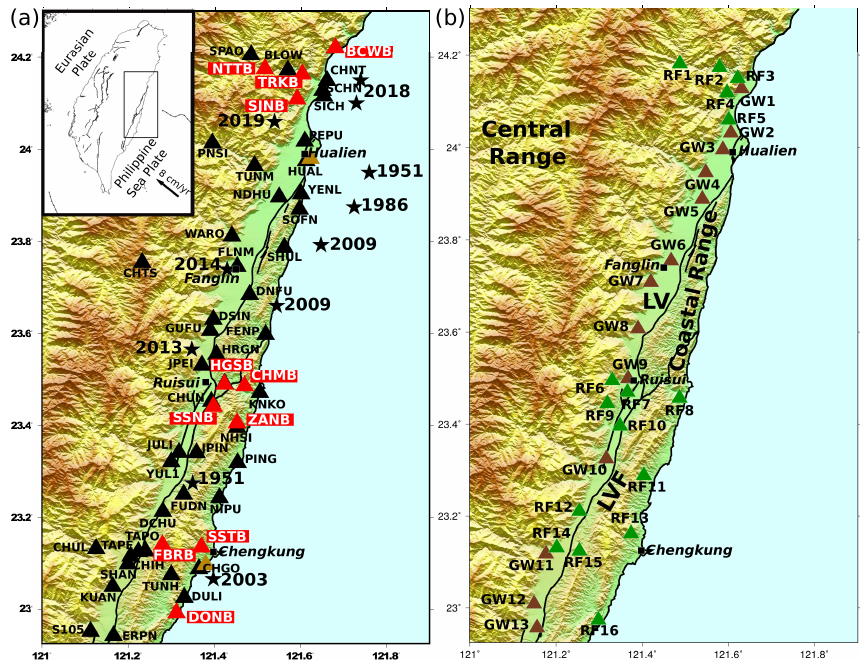
Figure 2. Map of station locations, topography, major faults and major cities in eastern Taiwan. ( a ) Earth and ocean deformation monitoring: red triangles indicate Sacks–Evertson borehole strain- meter (BCWB, NTTB and CHMB are permanently shut off in 2021), black triangles denote continuous GNSS stations and brown triangles indicate tide-gauges operated by the Central Weather Bureau. Black stars denote major earthquakes in the region since 1950, from north to south: 2018 Hualien M w 6.1 and M w 6.4 sequence, 2019 M w 6.1 Hualien event, 1951 M L 7.3 Hualien-Taitung